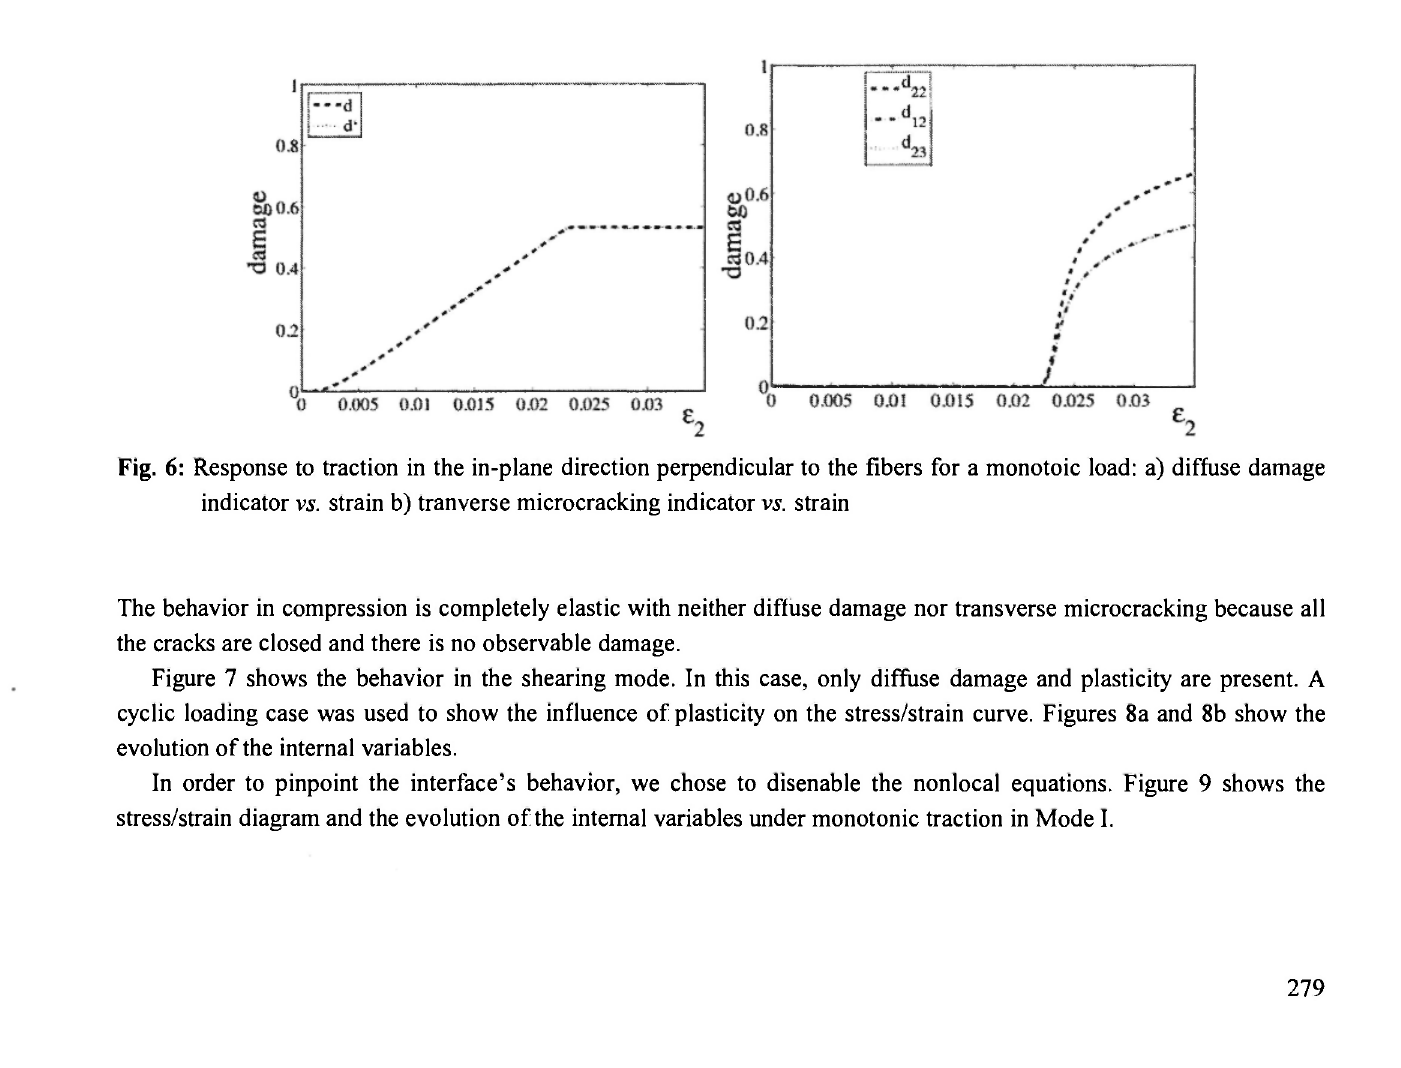
Fig. 5: Response to traction in the in-plane direction perpendicular to the fibers for a monotonic load: stress vs. strain